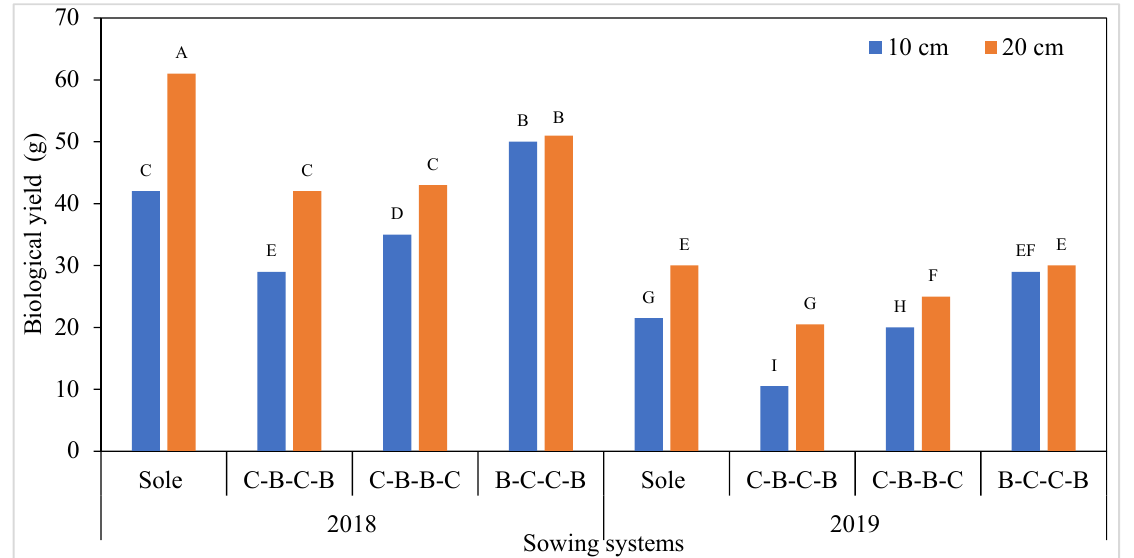
Figure 6. The interactions of maize–white bean sowing systems on protein ratio of maize and biological yield per white bean plant at Nur Sultan, Kazakhstan research station. Letters on each bar represent a significance level at p < 0.01. Note: different letters denote significant differences, while the same letters indicate insignificantly different values.